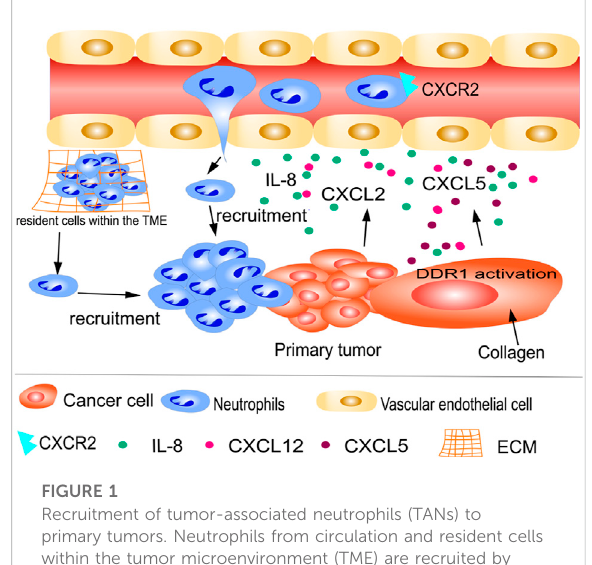
FIGURE 1 Recruitment of tumor-associated neutrophils (TANs) to primary tumors. Neutrophils from circulation and resident cells within the tumor microenvironment (TME) are recruited by cytokines, growth factors, and chemokines, such as IL-8 and CXCL2. Tyrosine kinase discoid domain receptor 1 (DDR1) is a key regulator of tumor cell metastasis. DDR1 activation by collagen in cancer cells is a signi fi cant stimulus for the synthesis of CXCL5, leading to the recruitment of TANs to primary